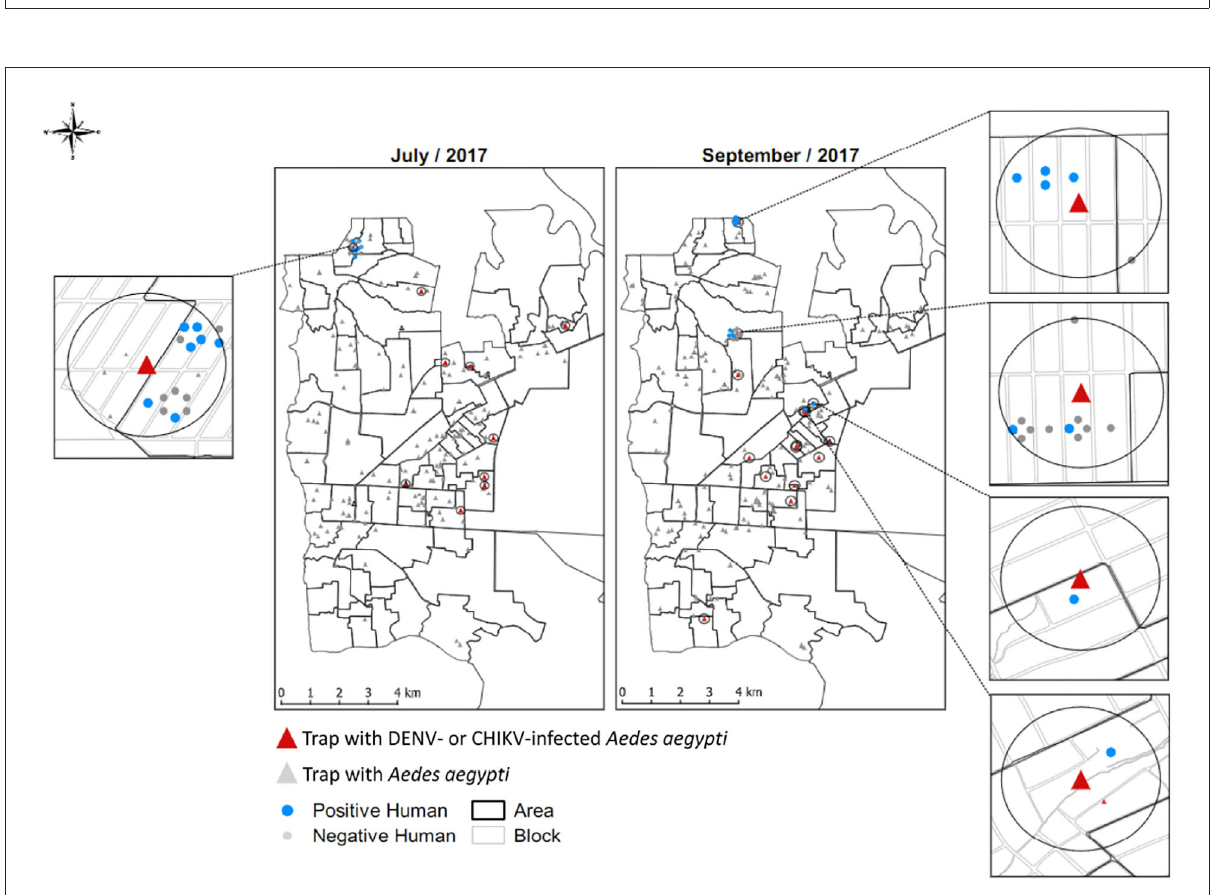
FIGURE2 Foz do Iguaçu city map divided into 73 areas, showing the location of Adultraps with Aedes aegypti and those later classified as DENV- or CHIKV-infected. Highlighted in the zoomed maps is the distribution of positive and negative householders after active